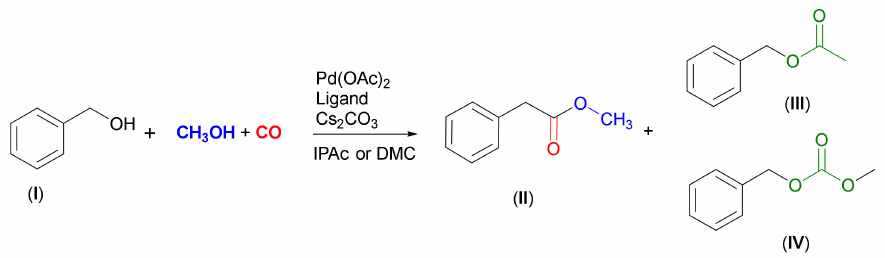
Table 1. One-pot methoxycarbonylation of benzyl alcohol ( I ). Entry a Ctz. P CO (Bar) Conv. (%) b Yield b 1 Pd(OAc) 2 50